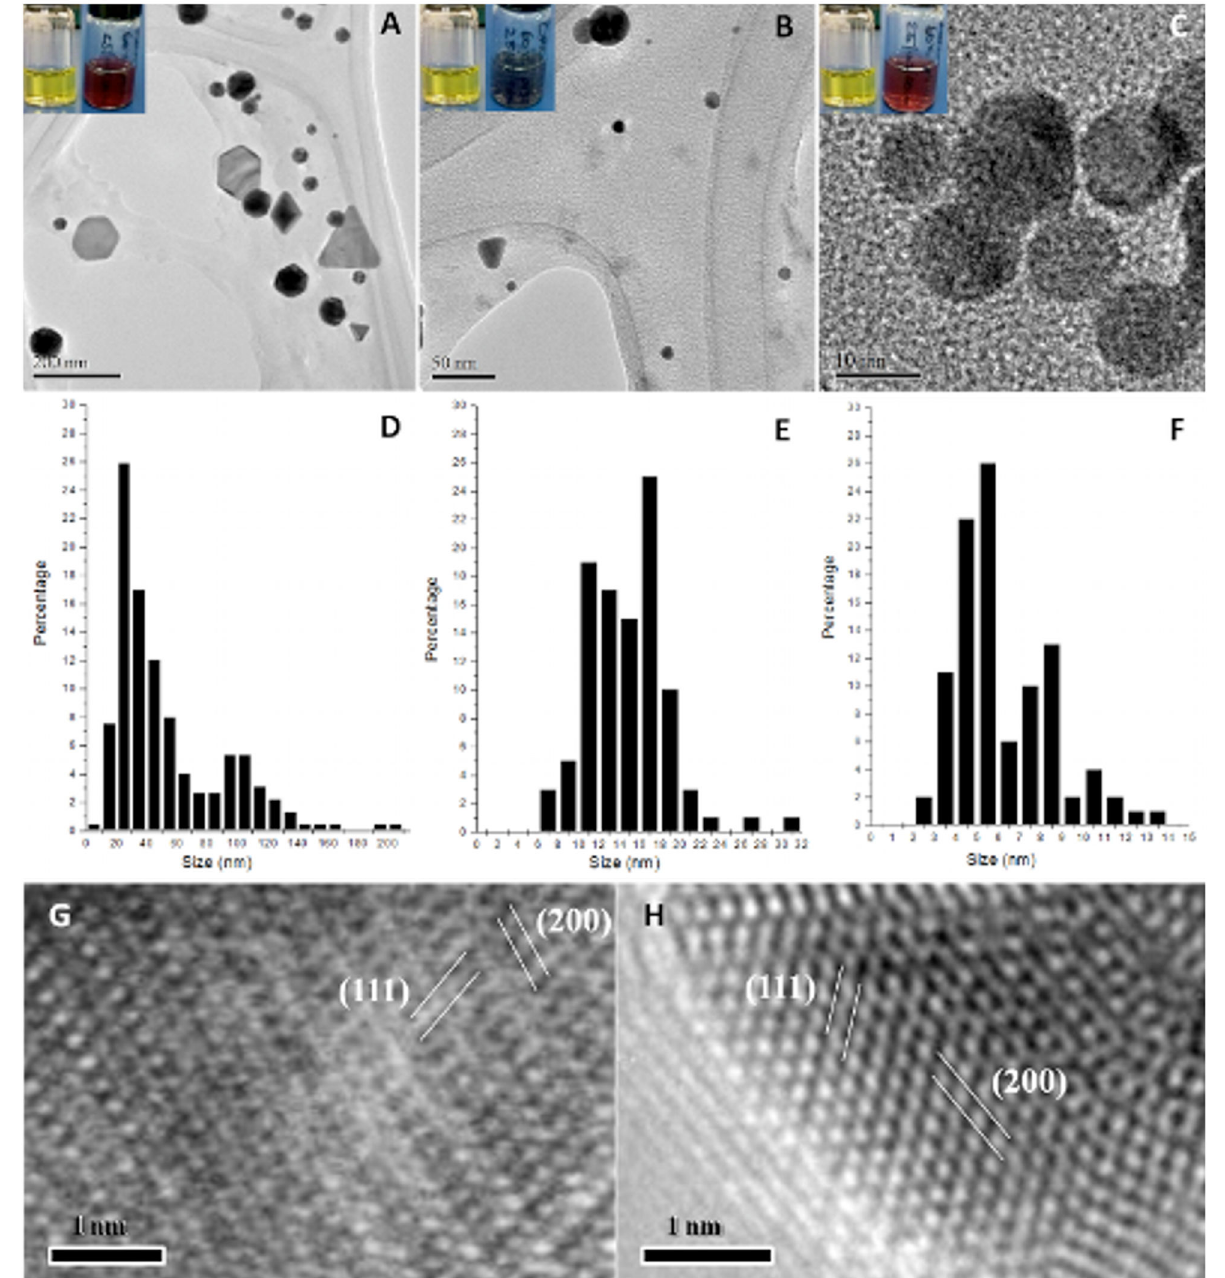
Figure 1. TEM analysis. Gold nanoparticles synthesized by N. crassa extract at 60°C and pH 3 (A), pH 5.5 (B), and pH 10 (C). Insets: color change from before (yellow; left image) to after (red / purple; right image) incubation. D-F: Corresponding size distribution histograms of formed nanoparticles. G-H: HRTEM images of a quasi-spherical (G) and a hexagonal (H) gold nanoparticle with plane information. Gold nanoparticles synthesized by N. crassa extract at 60°C and pH 3 resulted in the formation of different shapes in a broad size range, incubation at 60°C and pH 5.5 results in the formation of mostly quasi-spherical particles and some different shapes, mainly triangles, with a main size range of 6 to 23 nm, and incubation at 60°C and pH 10 shows formation of quasi-spherical particles in a very small size range (3 to 12 nm).